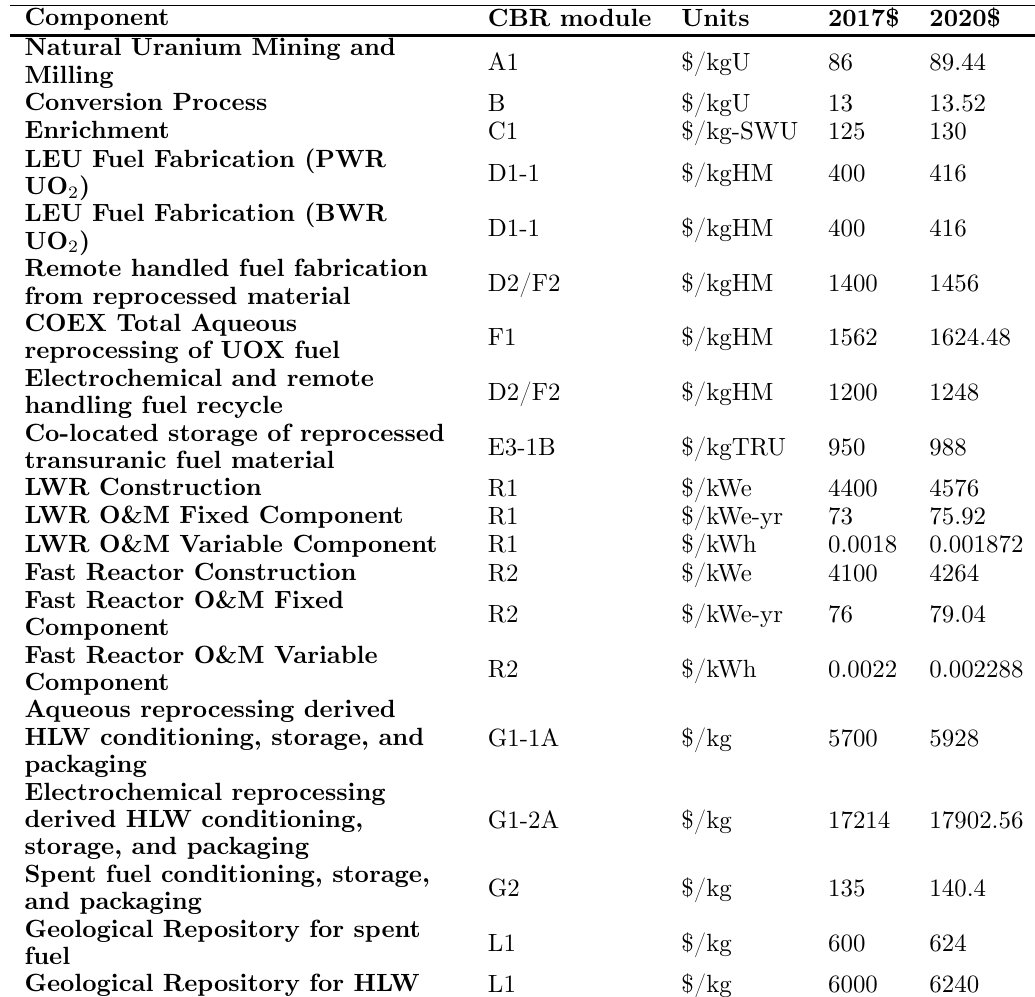
Table 2. Fuel cycle costs from table S-1 in 2017 cost basis report [3].